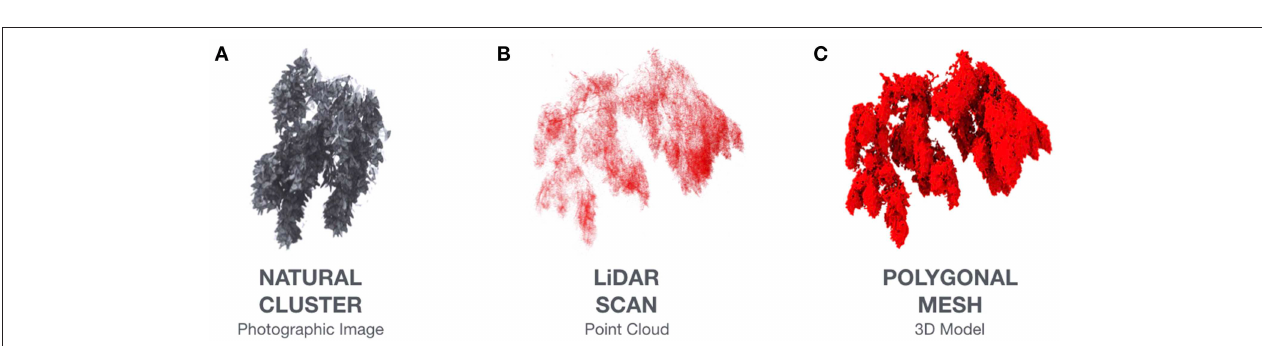
FIGURE 2 | Visual representation of 3 steps of the TLS/SVE workflow from data acquisition of a natural cluster (A) , to the generation of point cloud data (B) , to the conversion to a polygonal mesh (C) that can be manipulated and